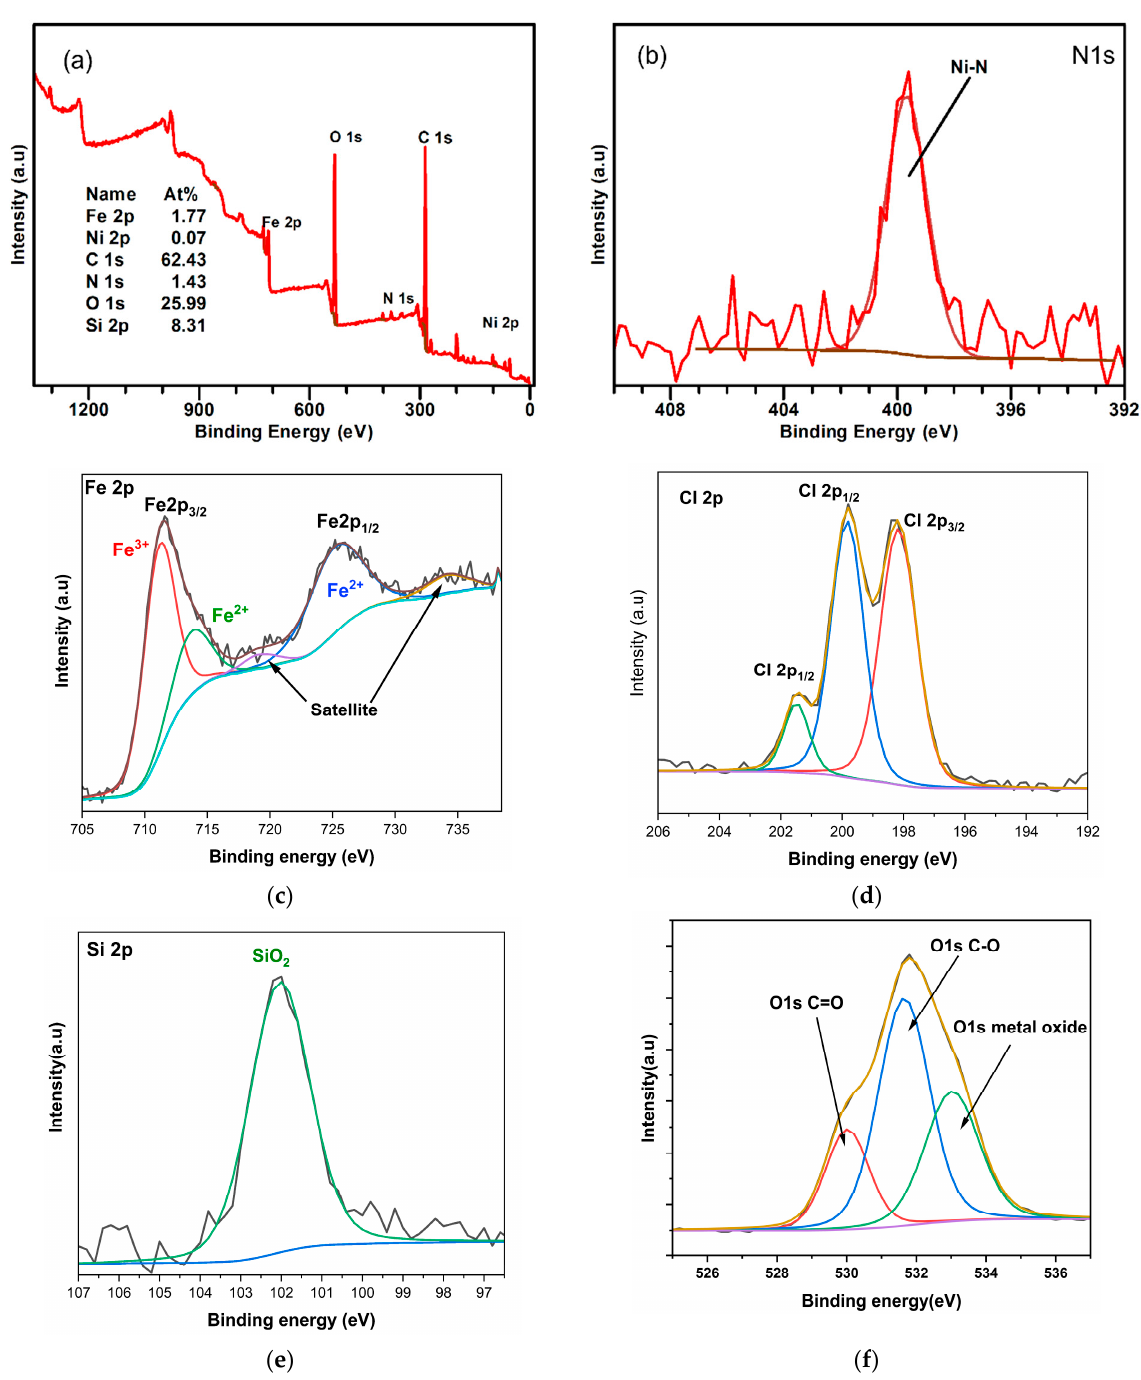
Figure 5 . ( a ) Survey of Fe 3 O 4 @C2 catalyst, ( b ) The N 1s high-resolution spectrum, and analysis for: Fe2p ( c ), Cl2p ( d ), Si2p ( e ) and ( f ) C1s elements in Fe 3 O 4 @C2 catalyst . Fe2p ( c ), Cl2p ( d ), Si2p ( e ) and ( f ) O1s elements in Fe 3 O 4 @C2